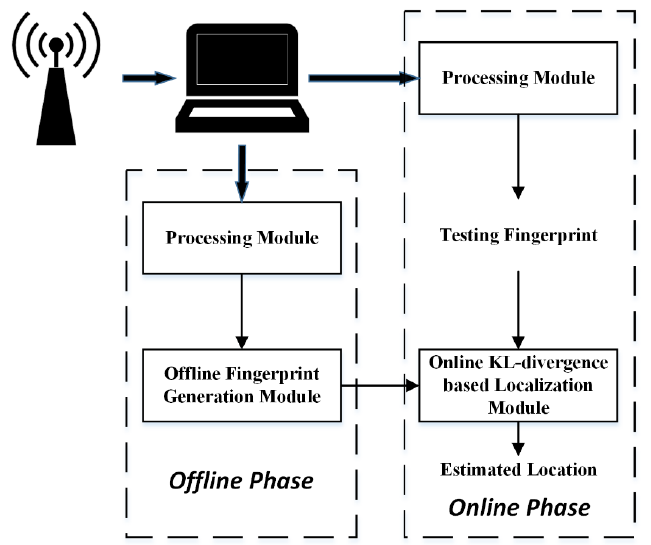
Figure 11. The architecture of the proposed approach.